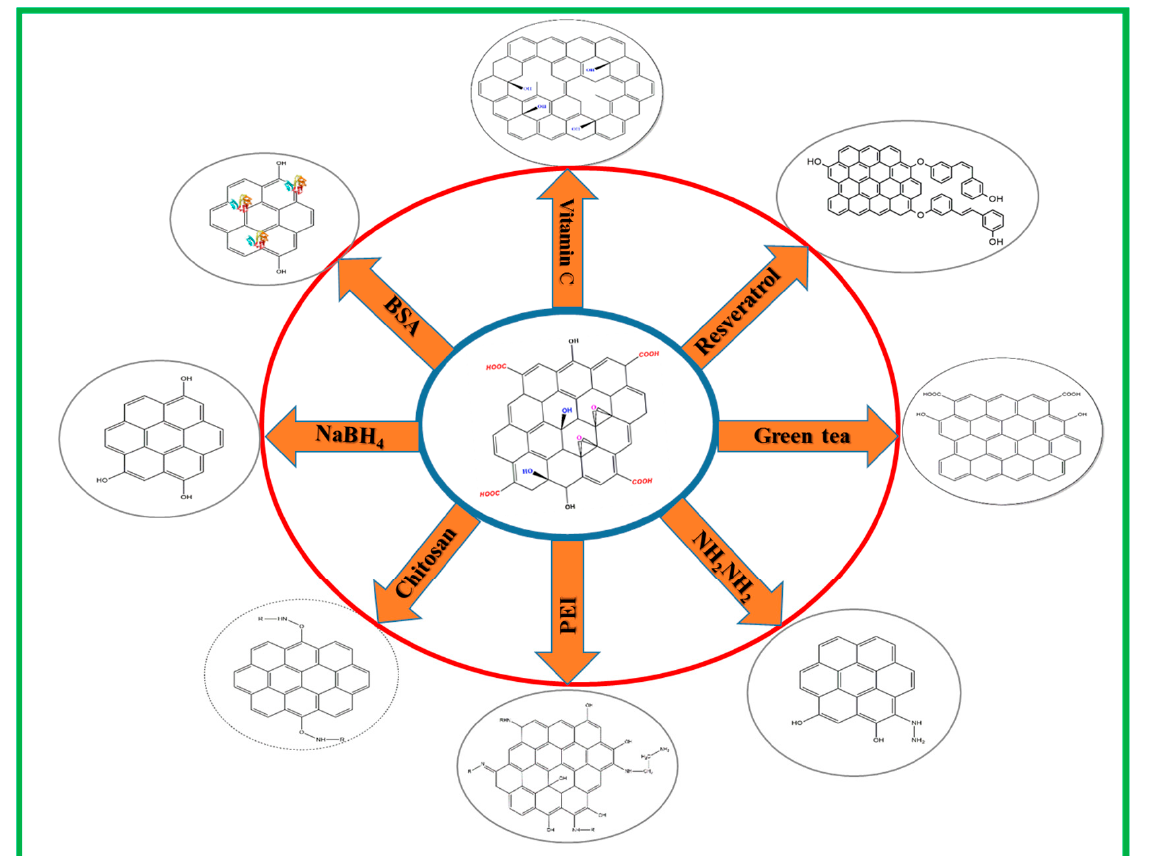
Figure 1. Schematic diagram illustrating the preparation of rGO from GO using different chemical reducing agents. BSA, bovine serum albumin; PEI, polyethyleneimine.